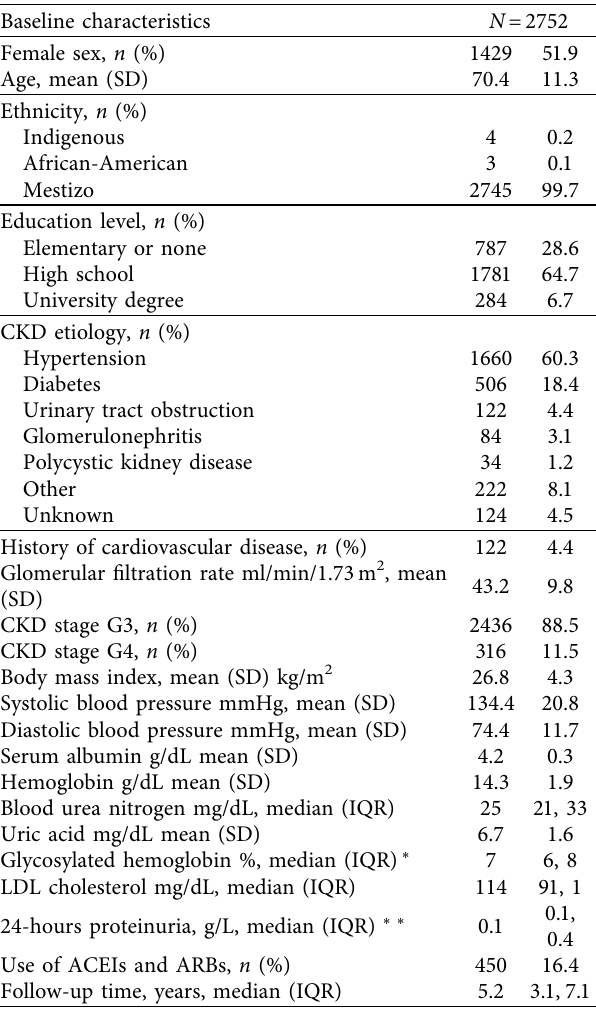
Table 1: Baseline characteristics of the study